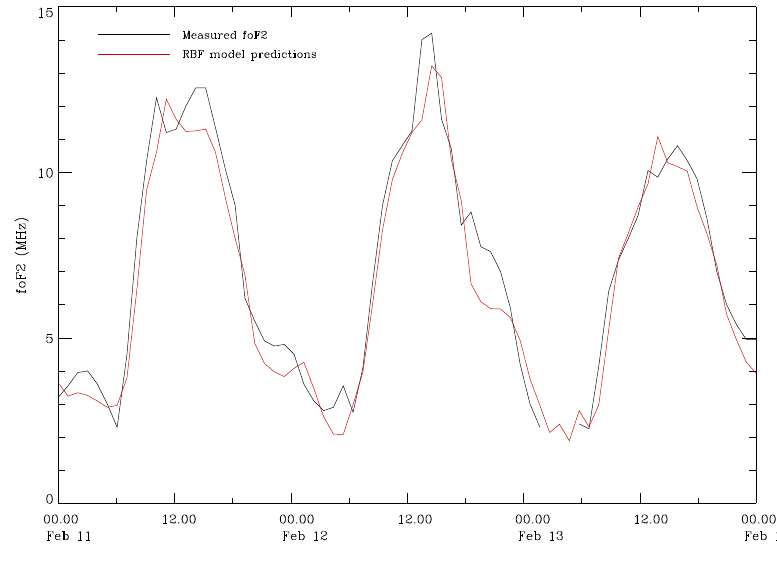
Fig. 1. Measured fo F2 and 1-hour ahead forecasts during a storm event in February 2000. The gap in the mea- sured fo F2 time series represent missing